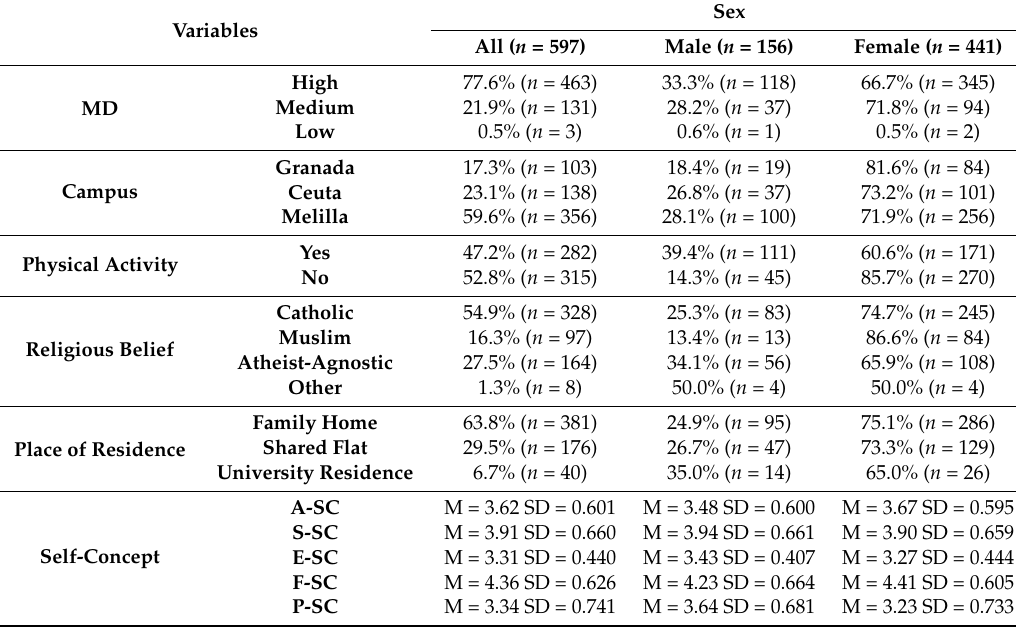
Table 2. Characteristics of study sample according to sex.